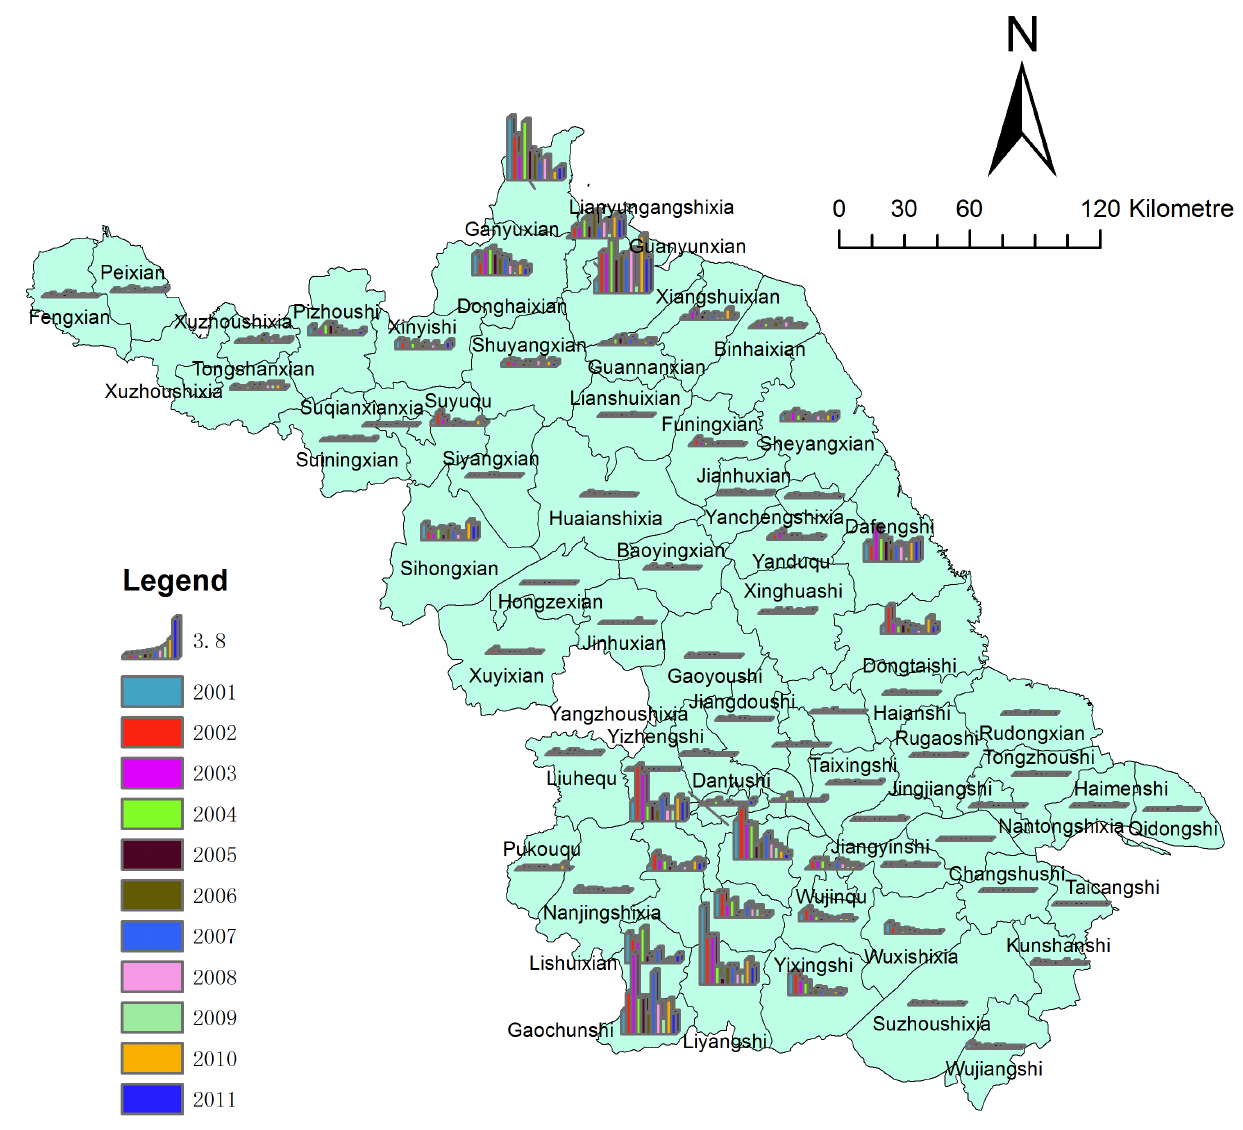
Figure 2. The density of HFRS cases based on counties in Jiangsu from 2001 to 2011. The mean annual incidence per 100,000 residents in each county of Jiangsu is shown. Different colors represent different years.